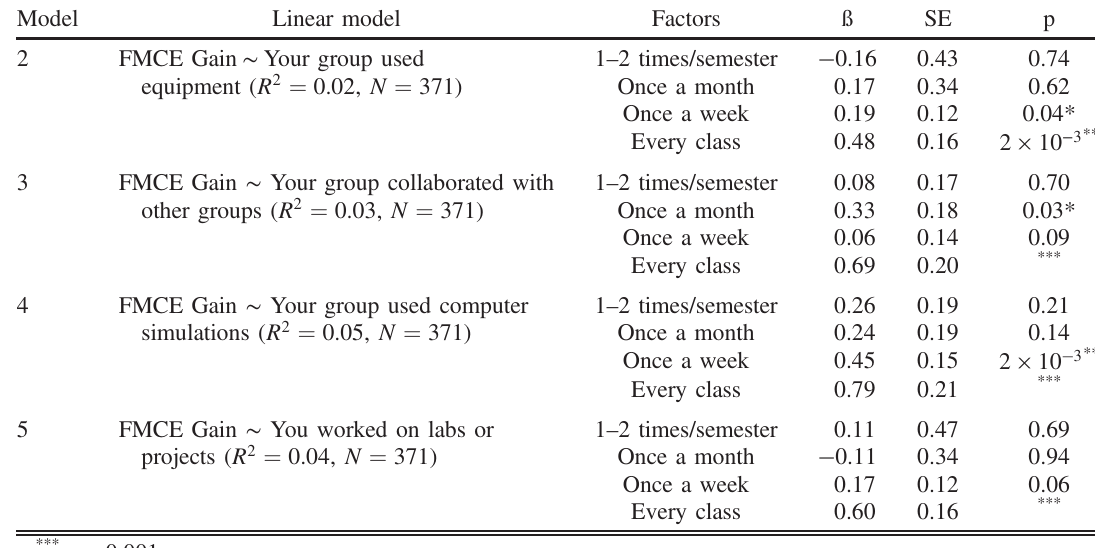
TABLE II. Linear regression for FMCE and frequency of small group activities.